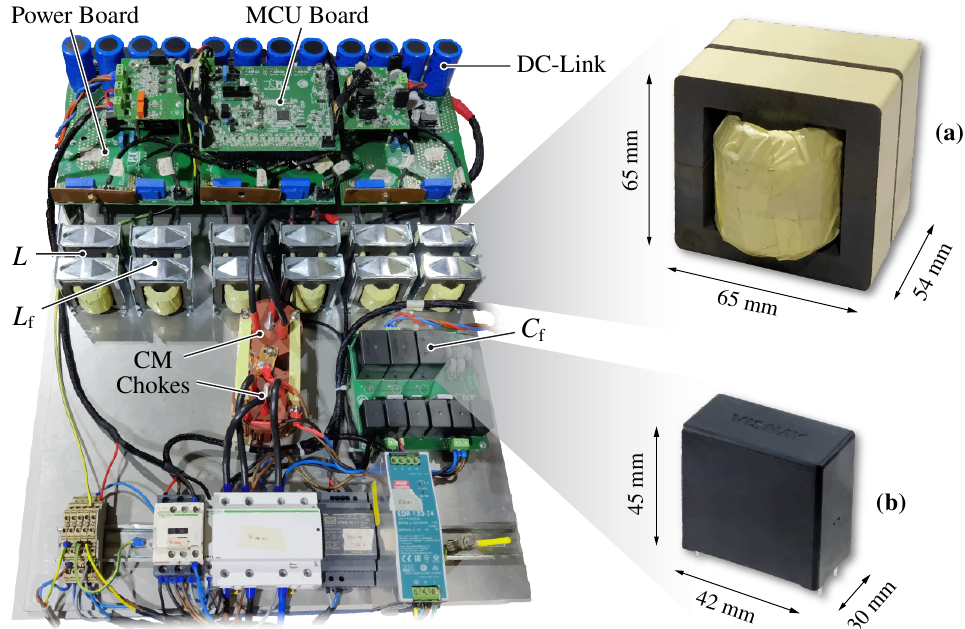
Figure 13. Overview of the active front-end (AFE) prototype utilized for the experimental tests, with highlight of ( a ) the realized inductor ( L = L f ) and ( b ) the selected capacitor ( C f ).